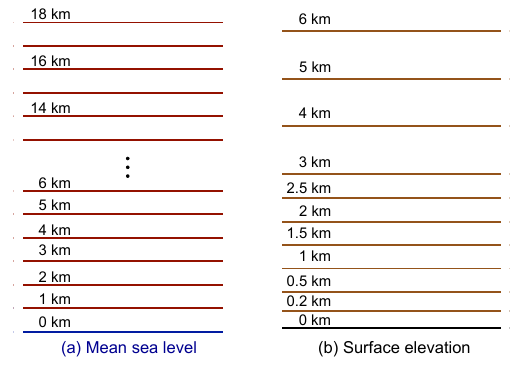
Figure 3. The vertical layers saved in the CCARA dataset. (a) Mean sea level layers (MSL layers) are defined with respect to sea level and capture the full atmospheric column. (b) Planetary boundary layer layers (PBL layers) are defined with respect to surface eleva- tion and capture the boundary